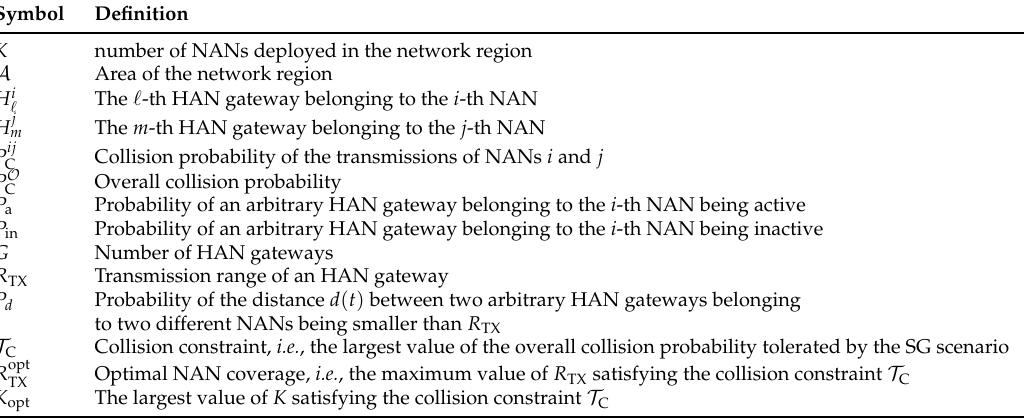
Table 1. Adopted